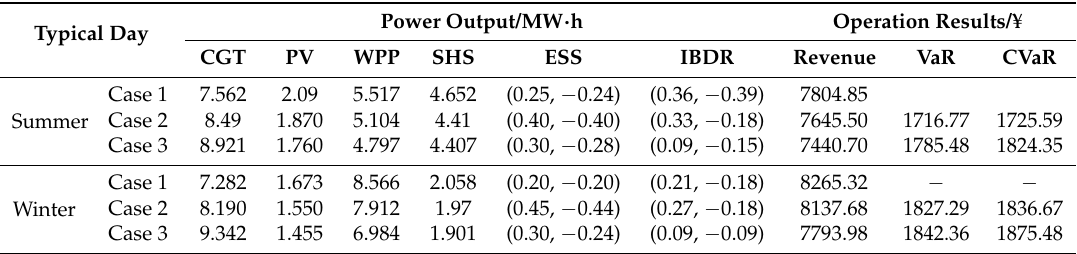
Table 4. Scheduling results of VPP operation in different Cases.